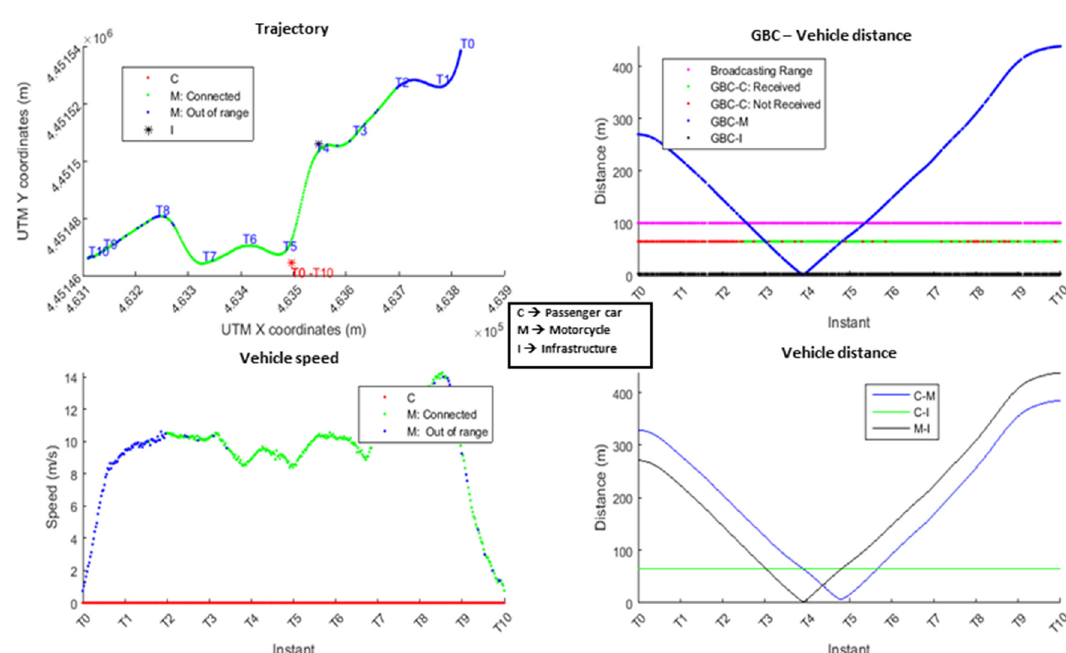
Figure 12 . Results of Test 4 with RSU. Figure 12. Results of Test 4 with